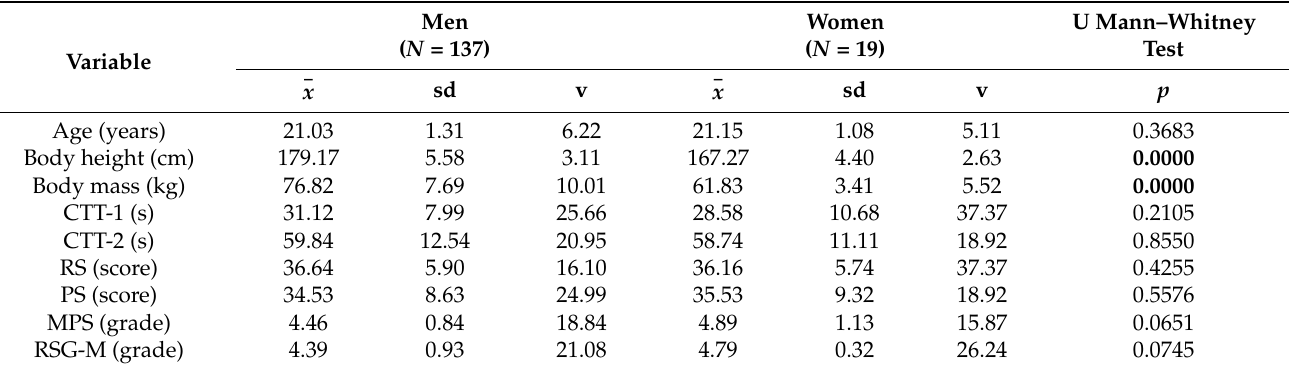
Table 1. Variation in mean CTT scores and shooting performance by Mann–Whitney U test for independent samples between men and women. Variation coefficients in bold are significant with p <